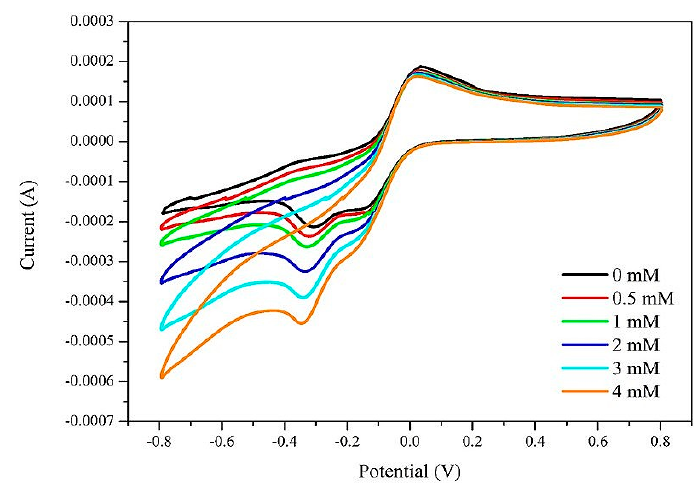
Figure 6. Cyclic voltammograms of the CuO–MBA–PAA / ITO electrode with di ff erent concentrations of H 2 O 2 at scan rate 100mV / s in 0.1M PBS (pH =